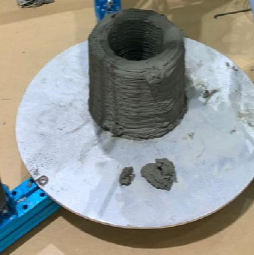
Fig. 11 Samples fabricated by additive manufacturing of